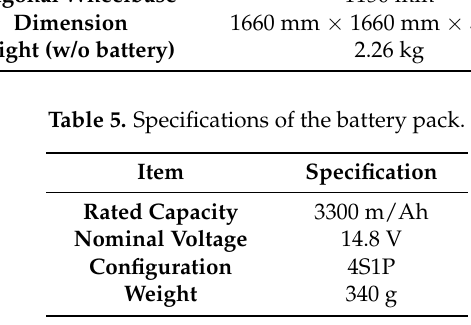
Table 4. Specifications of the UAV.